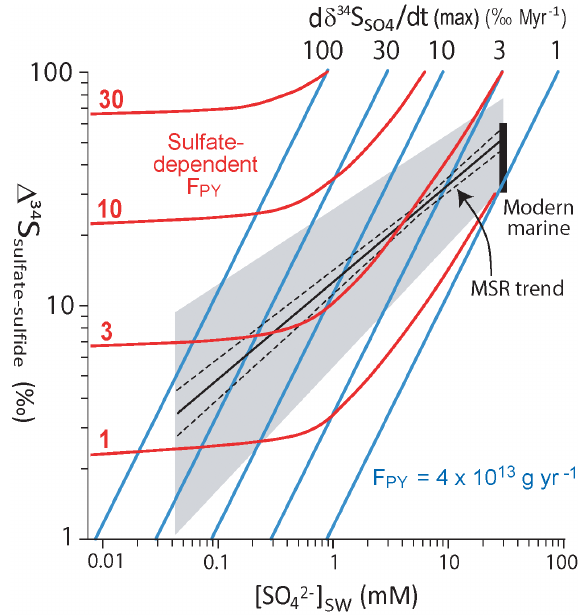
Figure A2. ∂δ 34 S CAS /∂t (max) values calculated using fixed pyrite burial fluxes (blue diagonal lines; cf. Fig. 1) and the sulfate-dependent pyrite burial fluxes of Wortmann and Chernyavsky (2007; red curves). Note that, for the latter curves, many combinations of the two measured sediment parameters ( (cid:49) 34 S CAS-PY and ∂δ 34 S CAS /∂t (max)) cannot yield a [SO 2 − estimate. Shown for reference is the MSR trend of Fig. 2.